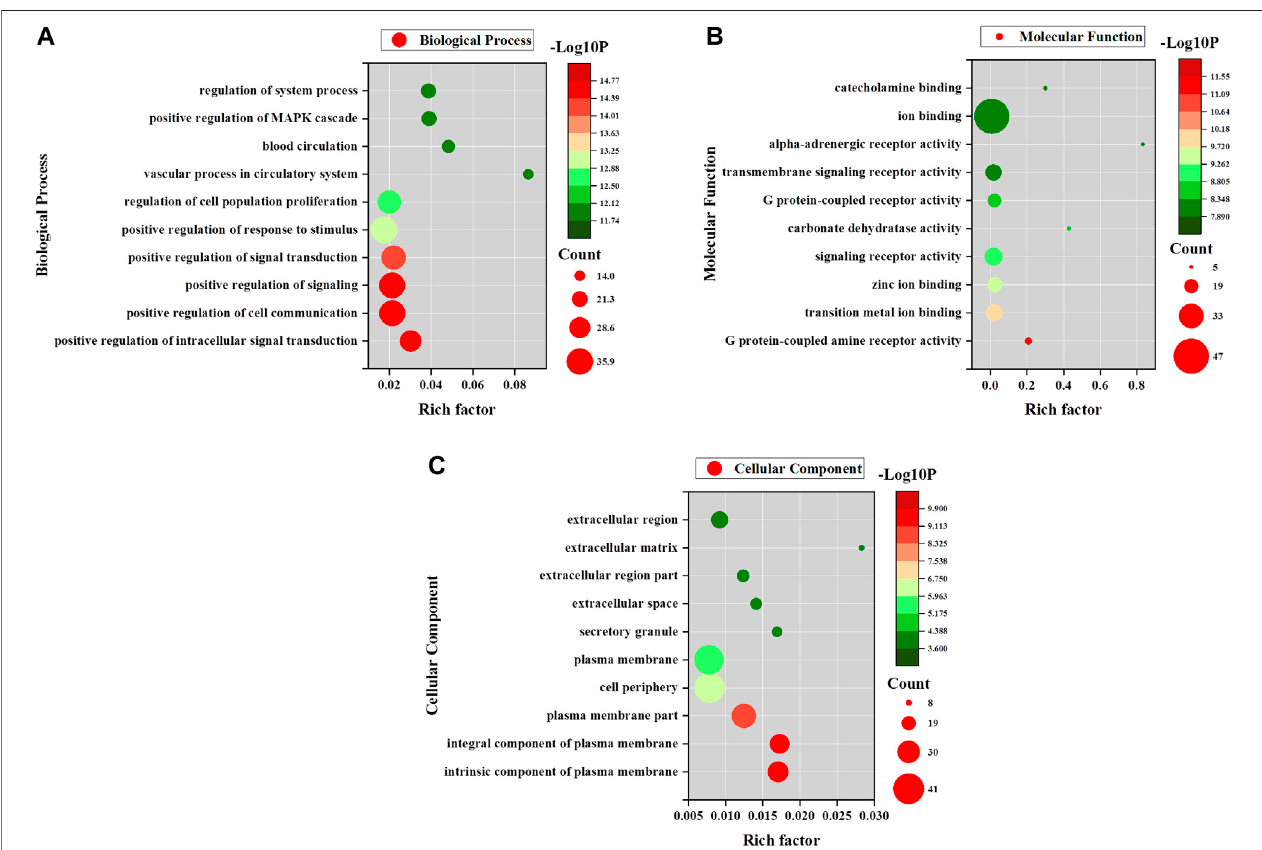
FIGURE 5 | GO enrichment analyses for AA. (A) Biological process enrichment of potential AA targets. (B) Molecular function enrichment of potential AA targets. (C) Cellular component enrichment of potential AA targets.